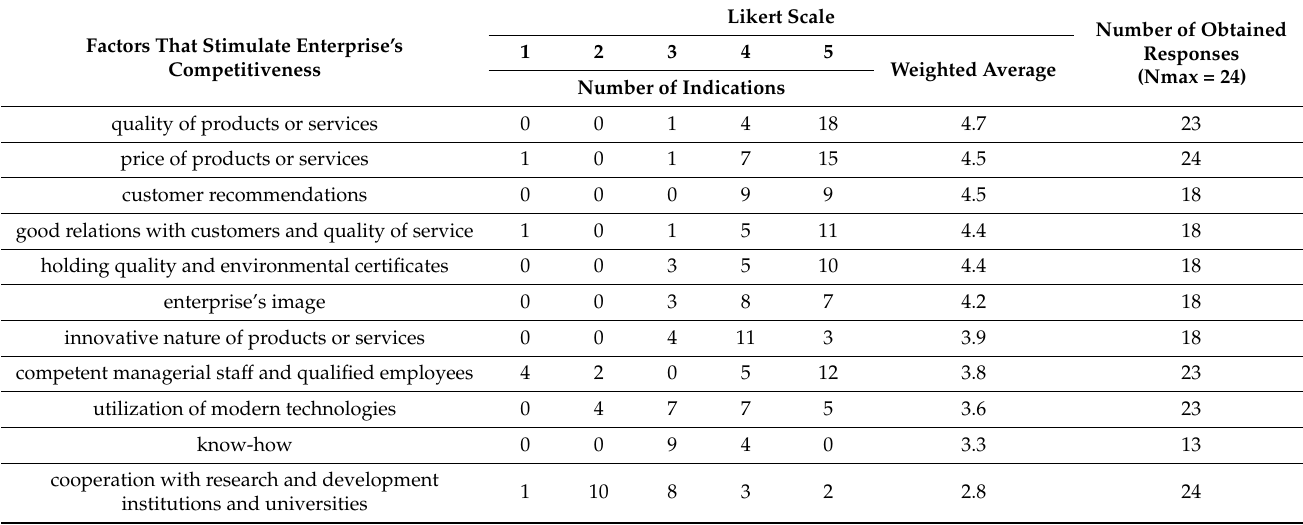
Table 5. Factors that stimulate competitiveness of design and construction enterprises of PV farms—Likert scale 1–5.